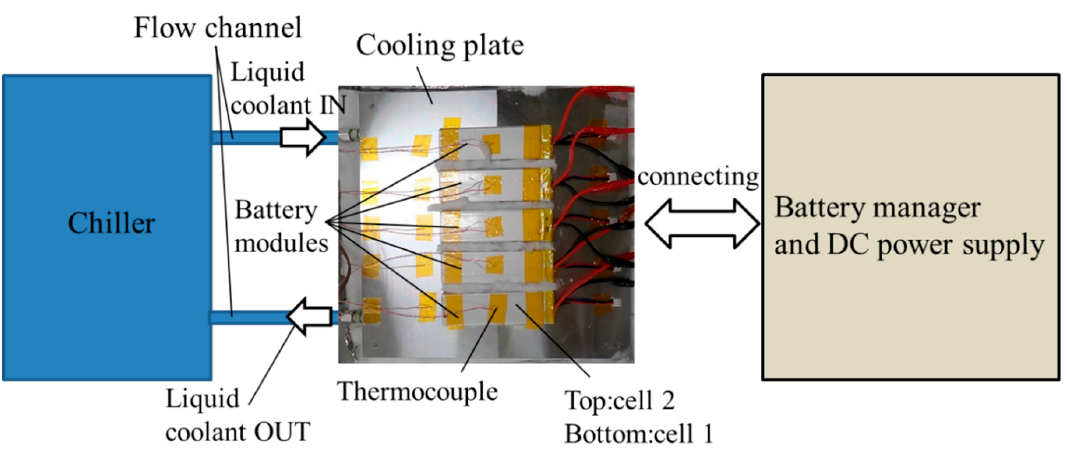
Figure 3. The schematic view of the test bench.